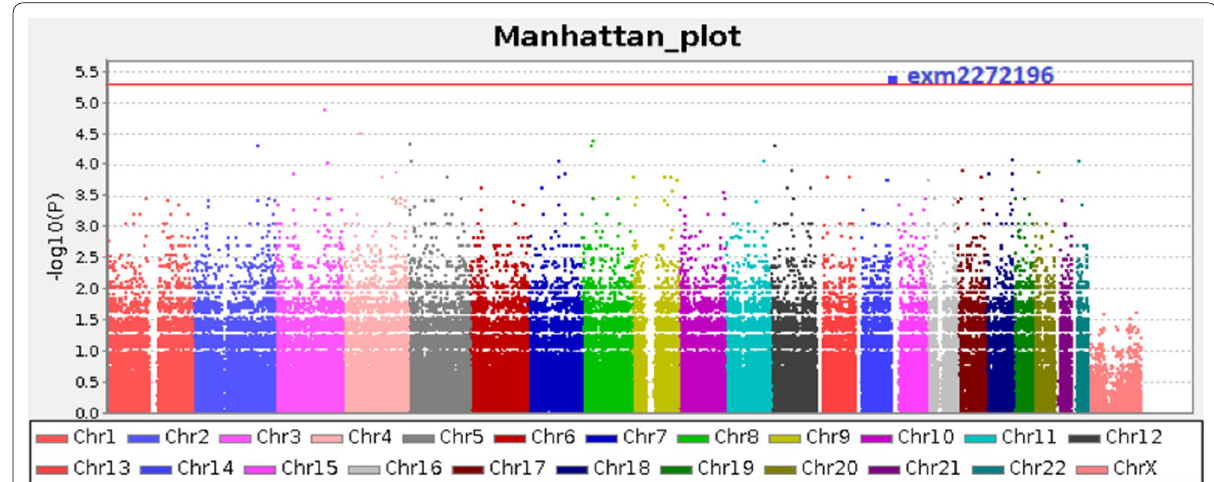
Fig. 3 Manhattan plot. This plot measures the level of statistical significance of association for each single nucleotide polymorphism. The horizontal red line shows the threshold at p